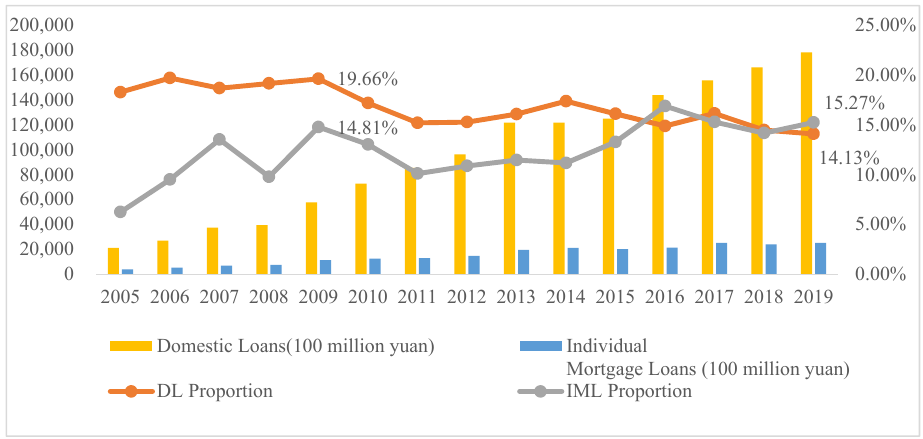
Figure 9. Individuals’ mortgage loans, developers’ domestic loans and proportions to the actual funds from 2005 to 2019. Sources: China Real Estate Yearbook from 2006 to